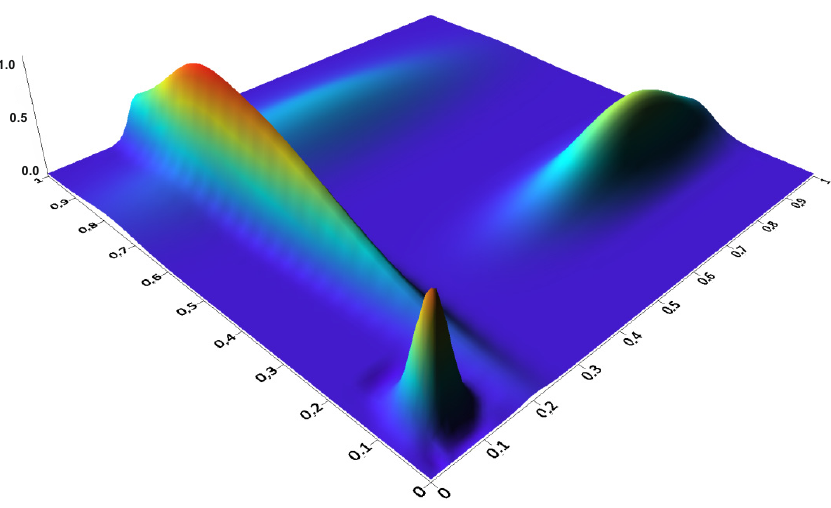
Figure 7. Test function (12) used to evaluate the quality of interpolation of GPR data. Table 3. Model building times for different RBFs at R 0 2 = 0.002. CS RBF